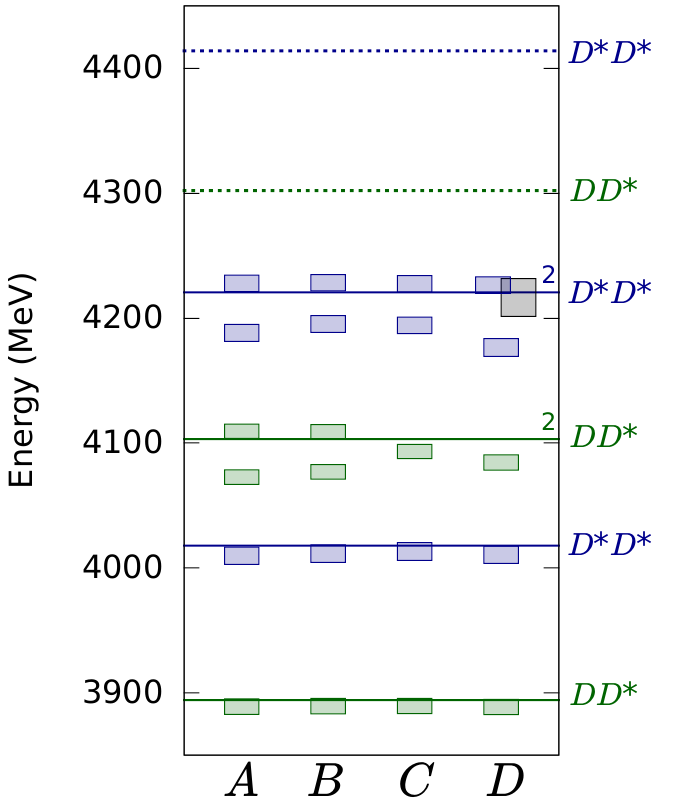
Figure 8 . As (cid:12)gure 6 but for the (cid:3) P = T + isospin-0 cc (cid:22) l (cid:22) l channel with di(cid:11)erent bases of operators: 1 A uses the full basis of meson-meson and tetraquark operators, B uses only meson-meson operators, C uses only meson-meson operators minus one DD (cid:3) operator as described in the text, and D uses the operators as in C supplemented with the tetraquark